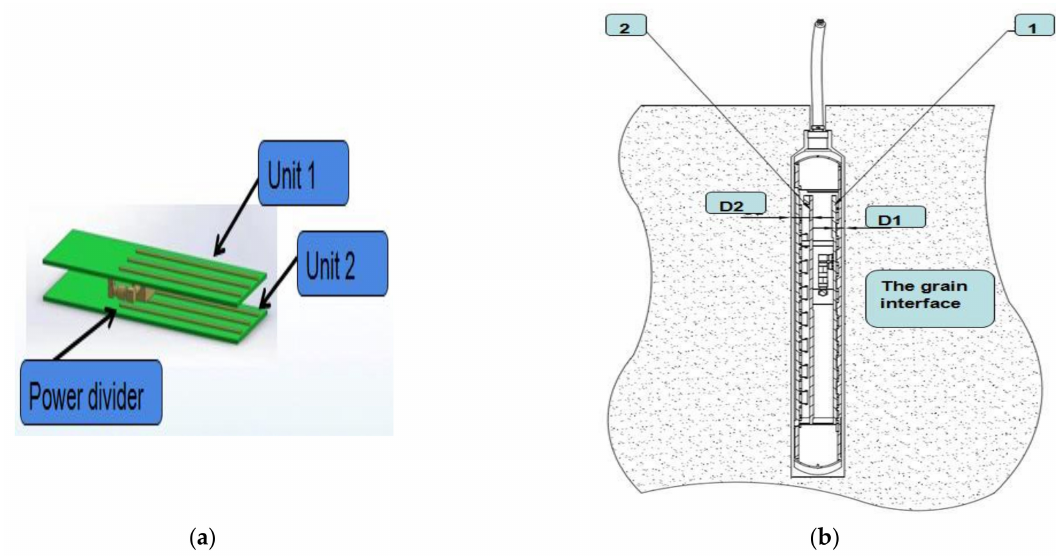
Figure 2. Working state diagram of the differential structure of the sensor: ( a ) Difference structure diagram. ( b ) 1: Detection Unit 1; 2: Detection Unit